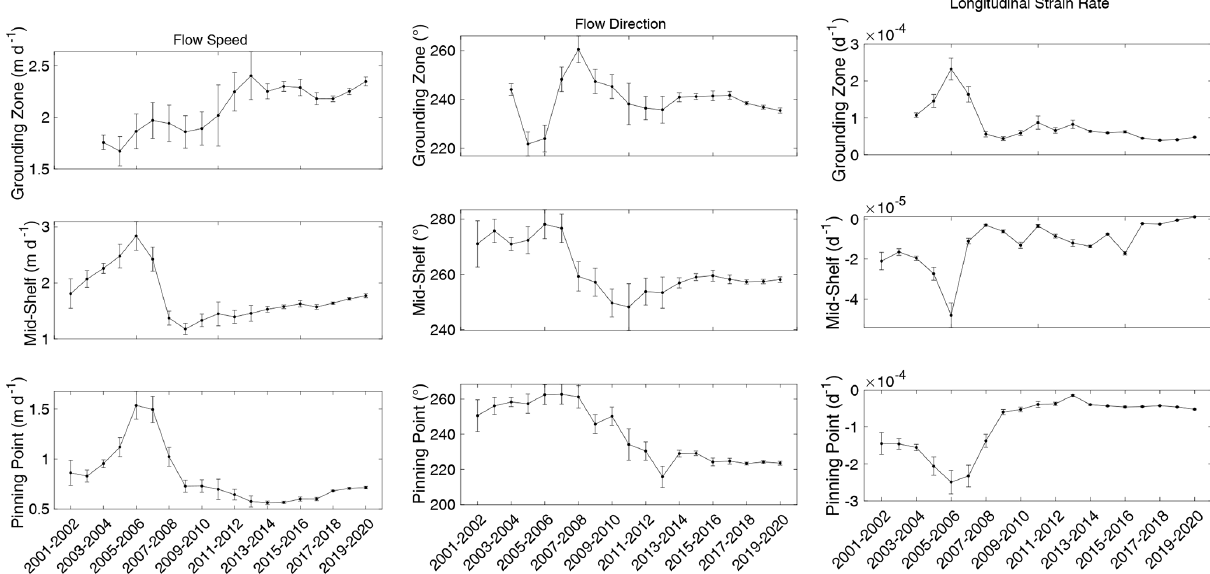
Figure 2. Average values of speed, flow direction, and longitudinal strain rate at the three sites of interest (locations shown in Fig. 1) for the 20-year velocity record.